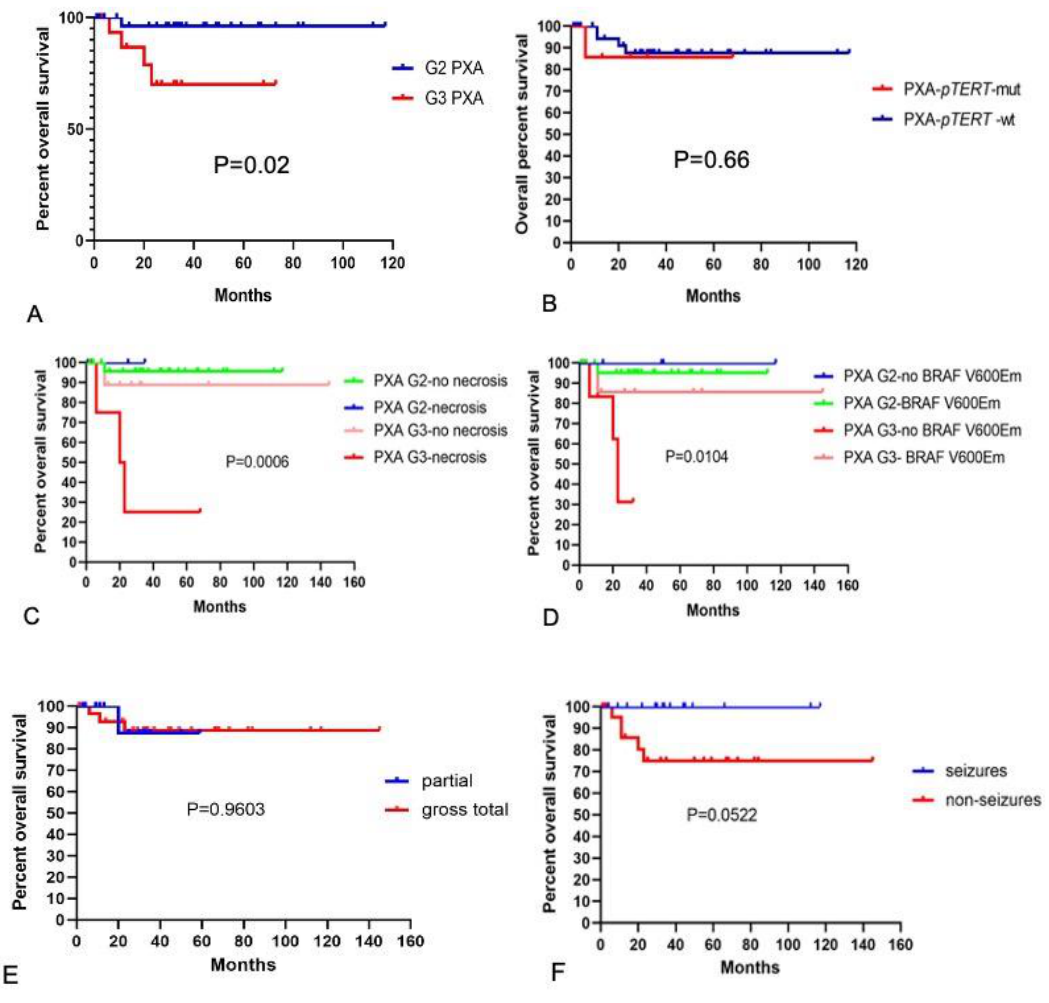
Figure 4. Overall survival of PXA. ( A ) Overall survival for grade 2 and 3 PXA. The blue line shows grade 2 PXA, and the red line depicts grade 3 PXA. The differences between the two groups were statistically significant ( p = 0.02). ( B ) Overall survival in the case of PXA with or without pTERT mutation. The blue line depicts PXA without pTERT mutation, and the red line depicts PXA with pTERT mutation. The differences between the two groups were not statistically significant ( p = 0.66). ( C ) Overall survival of different grades of PXA with and without necrosis. ( D ) Overall survival of different grades of PXA with and without BRAF V600E mutation. ( E ) Overall survival of different extension of resection. ( F ) Overall survival of PXA with and without epileptic symptoms. M , mut , mutation; wt ,